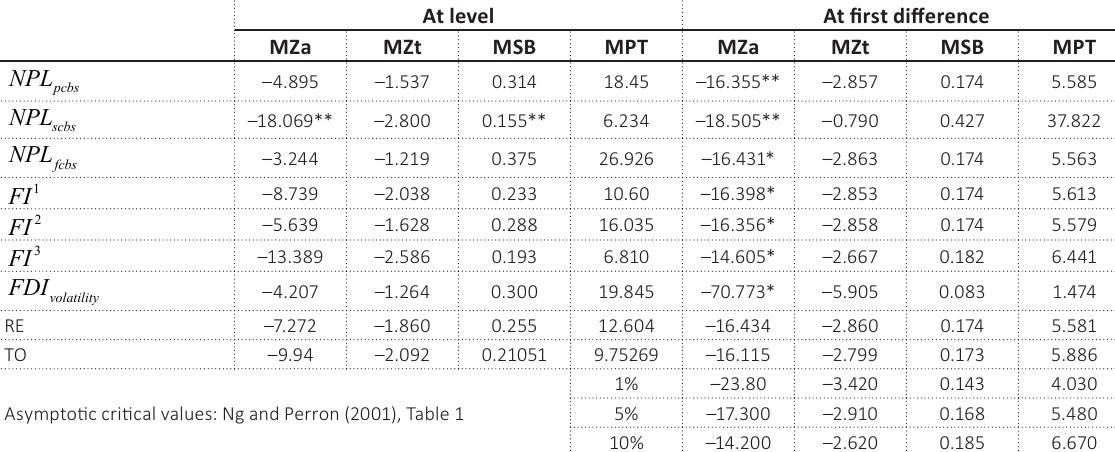
Table 4. Ng-Parron unit root